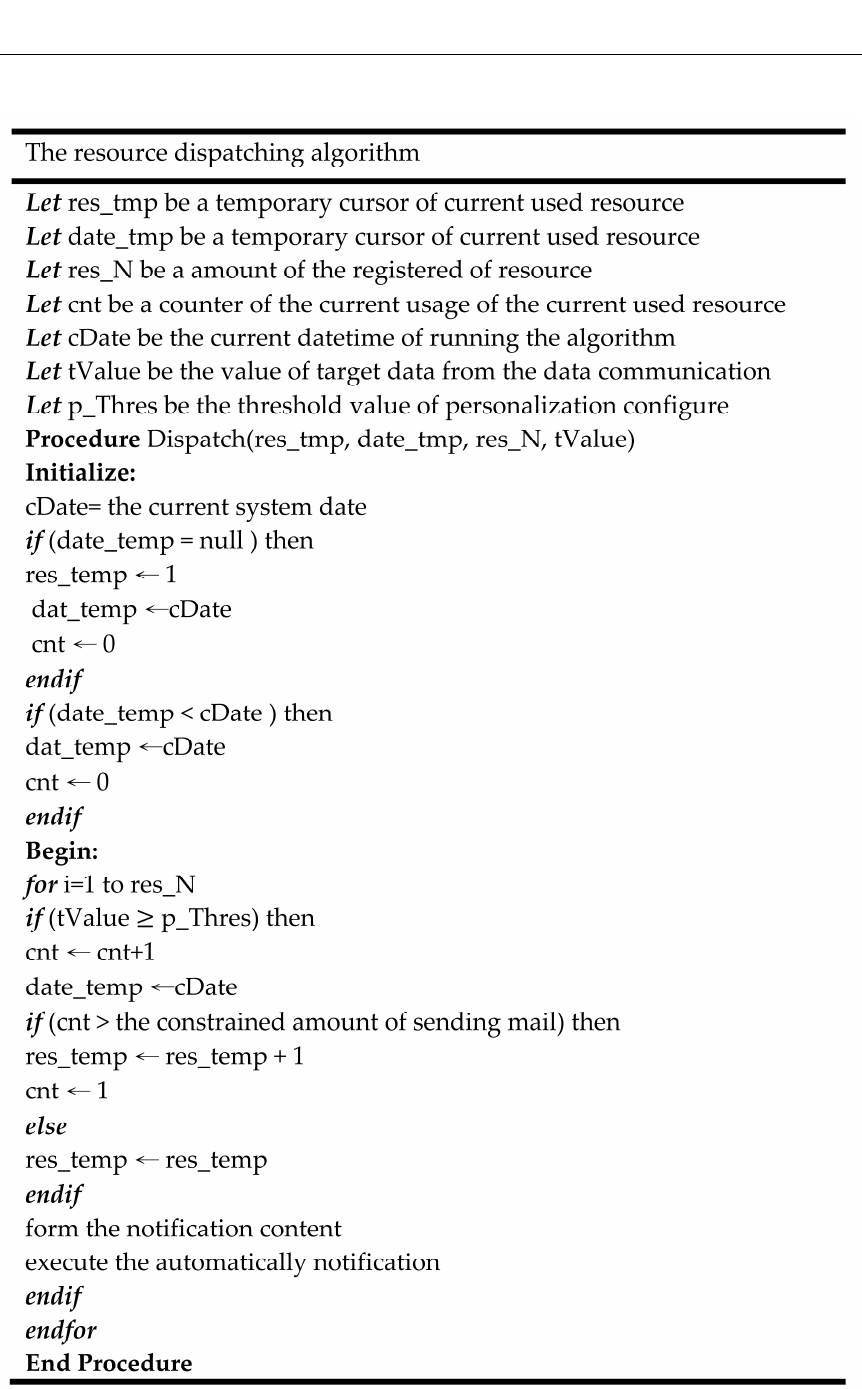
Figure 5. Procedure of industrial data analytics from import to deployment.